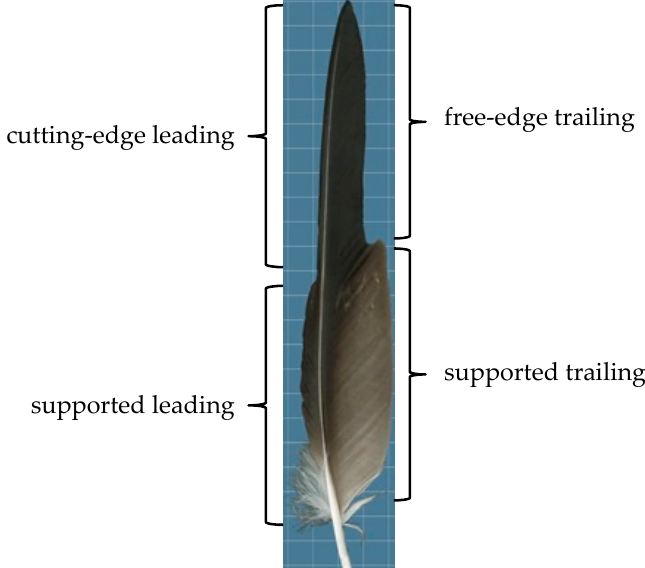
Figure 2. Four vane partitions recognized by aerodynamic functions: cutting-edge leading vanes, supported leading vanes, free-edge trailing vanes and supported trailing vanes.